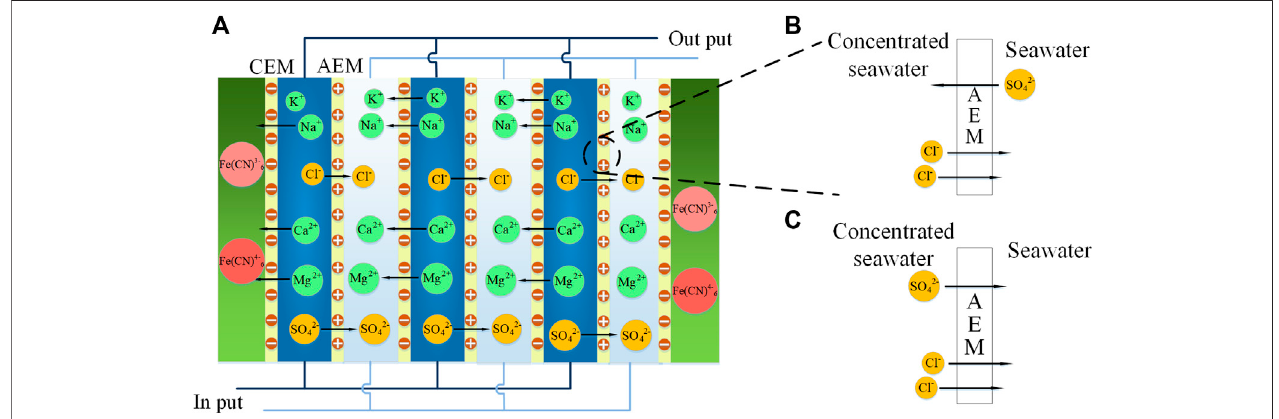
FIGURE 4 | Schematic diagram of ion in fl uence mechanism.